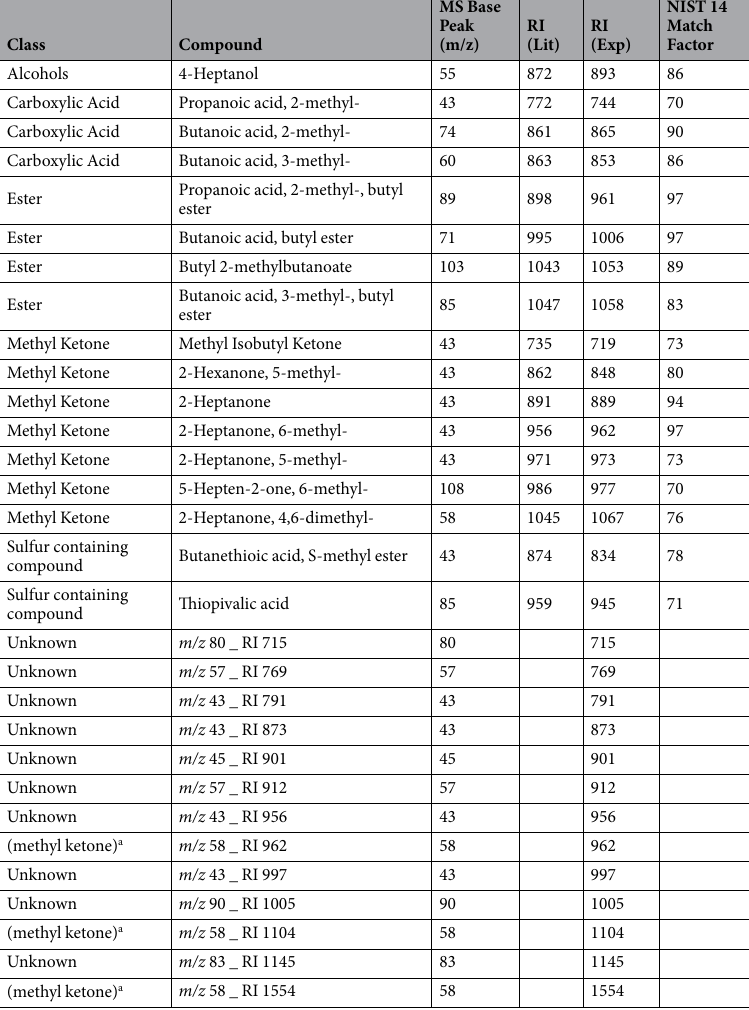
Table 3. Annotations of B. anthracis Sterne - specific VOC markers through compound class, putative NIST ID, m/z , and retention index matching. a GC/MS fragmentation similar to observed methyl ketones RI (Lit): Retention Index reported from NIST14 RI (Exp): Retention Index calculated from